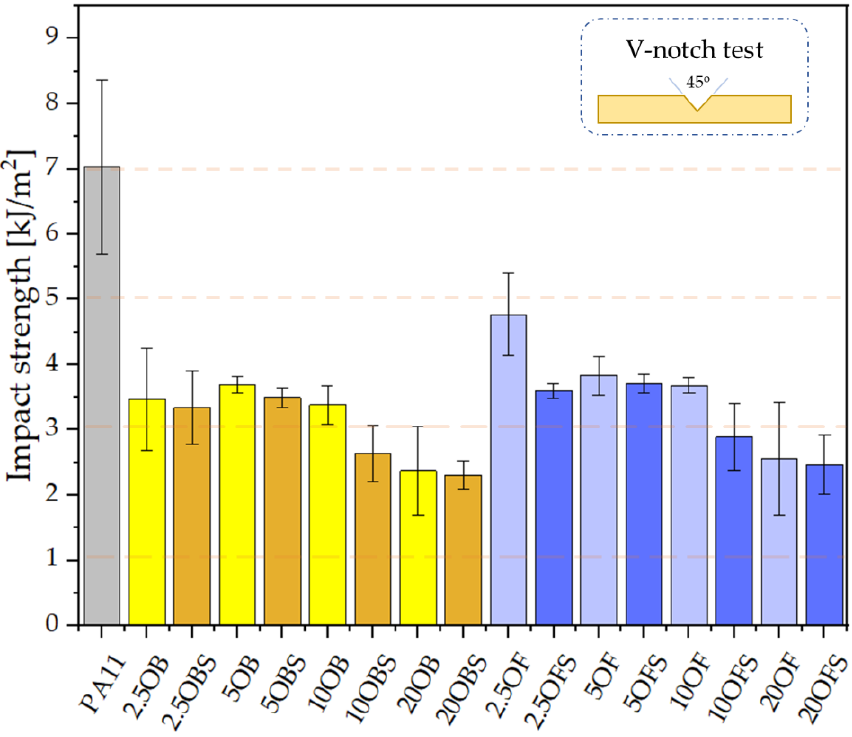
Figure 6. Impact strength of the composites after injection moulding: comparison of the composites containing diatomite filler with and without APTES